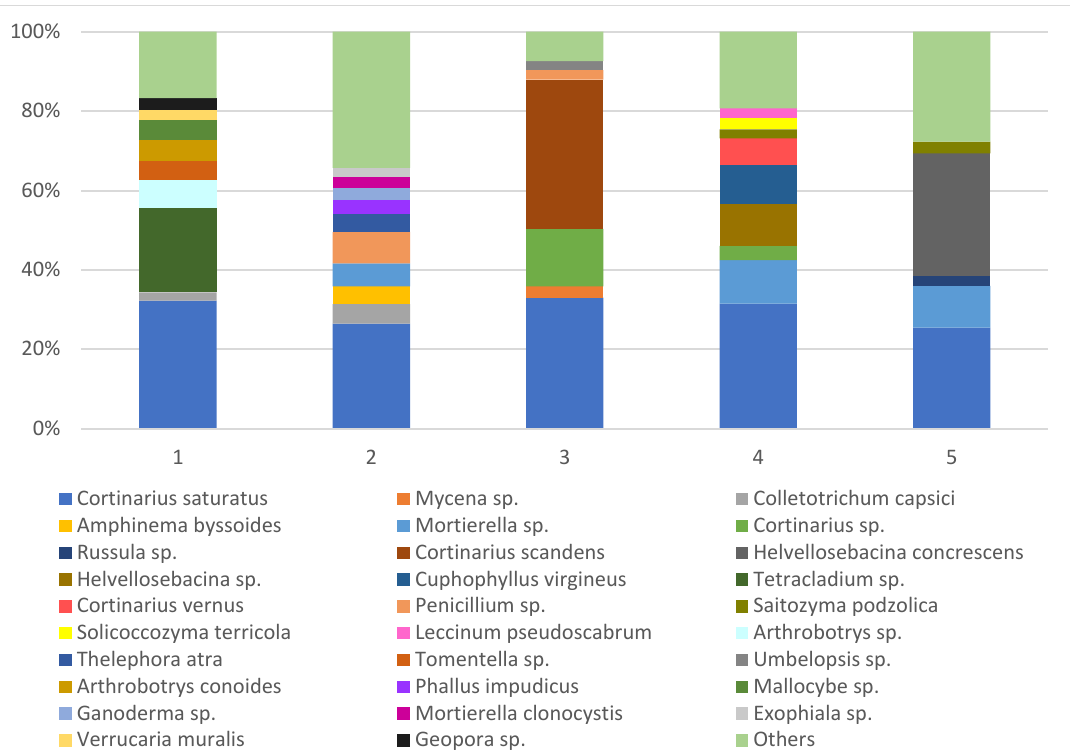
Figure 2. Fungal communities detected in the roots of orchids. (1) E. atrorubens (Dobšiná); (2) E. atrorubens (Jasenie); (3) P. bifolia (Jasenie); (4) E. pontica (Sirk); (5) C. longifolia (Sirk).